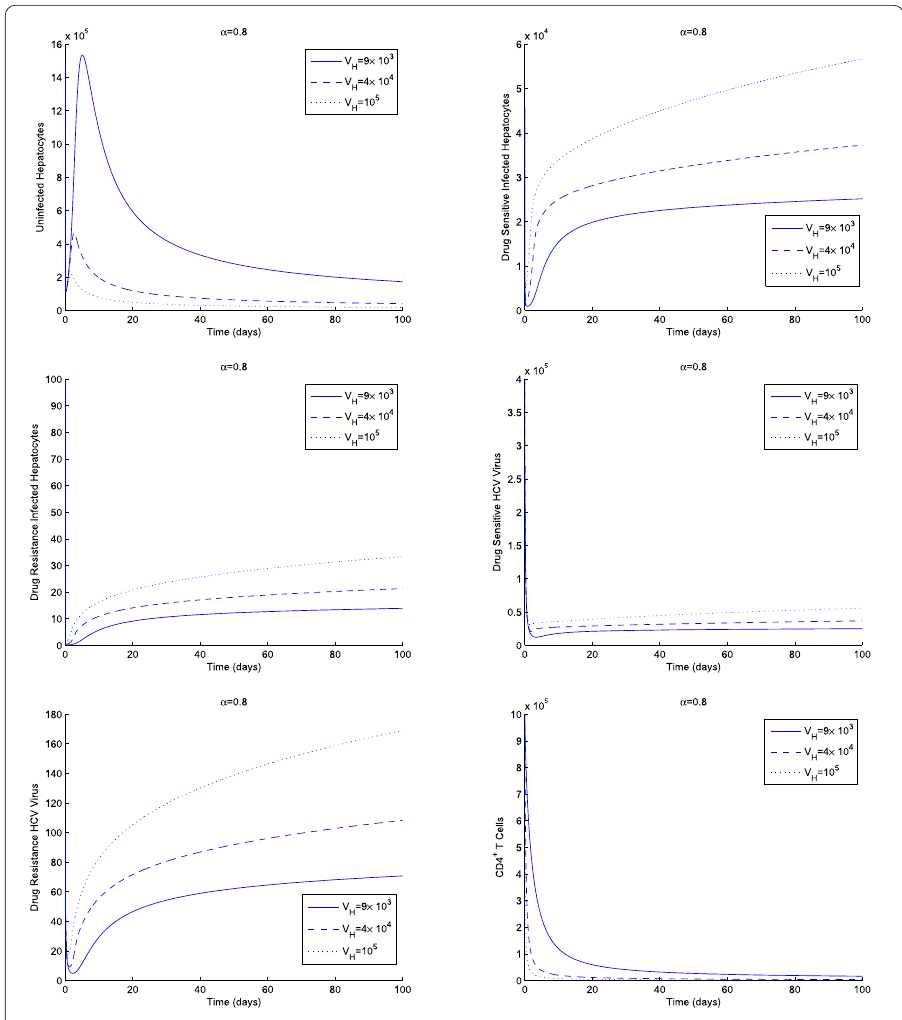
Figure 3 Dynamics of the variables of system (1) for different values of V H , the HIV viral load, and α = 0.8. Parameter values are in Table 1 and initial conditions are in the